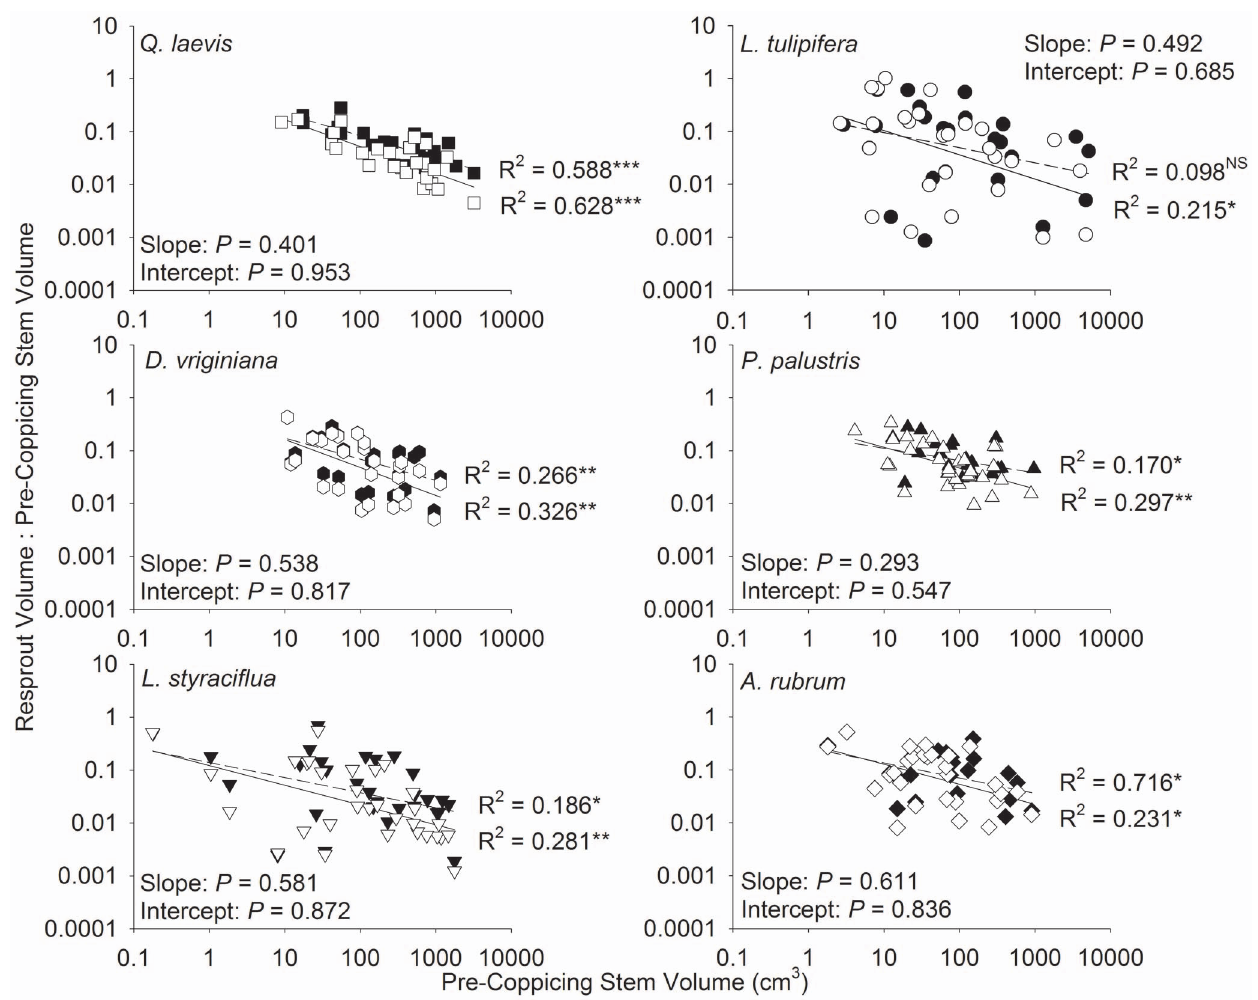
Figure 7. Relationships between pre-coppicing stem volume and the ratio of resprout volume to pre-coppicing volume. Data is shown on a logarithmic scale. Total stem volume is denoted with filled symbols and dashed lines. Maximum stem volume is denoted with open symbols and solid lines. * P , 0.05, ** P , 0.01, *** P , 0.001 for regressions; NS indicates not significant. P values for differences in slopes and intercepts between maximum and total volume are